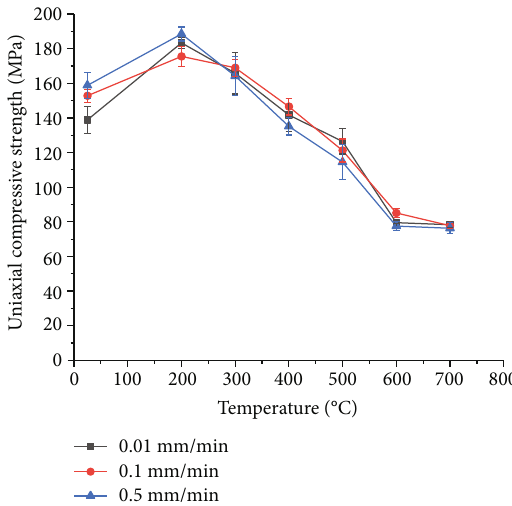
Figure 6: Relationship curves between elastic modulus and temperature of granite under real-time high temperature.